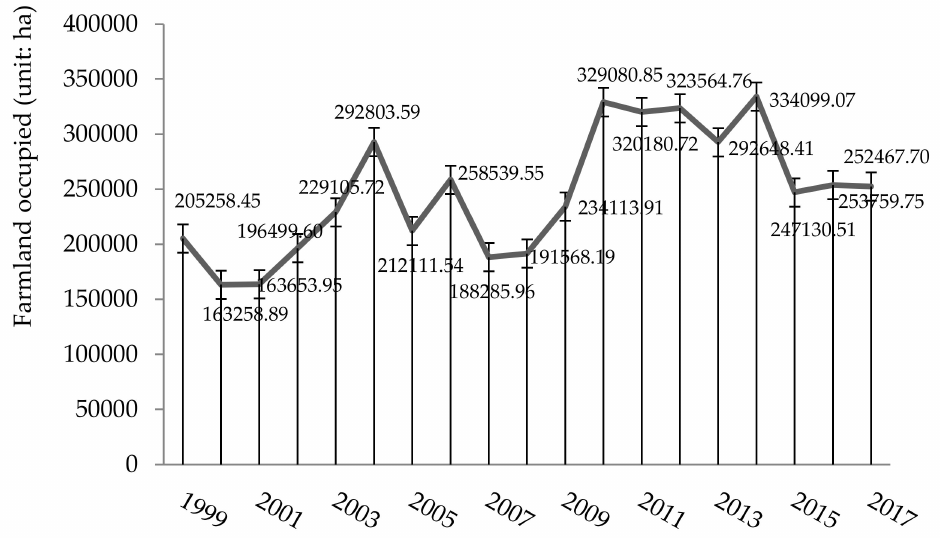
Figure 1. Farmland occupied for construction land use